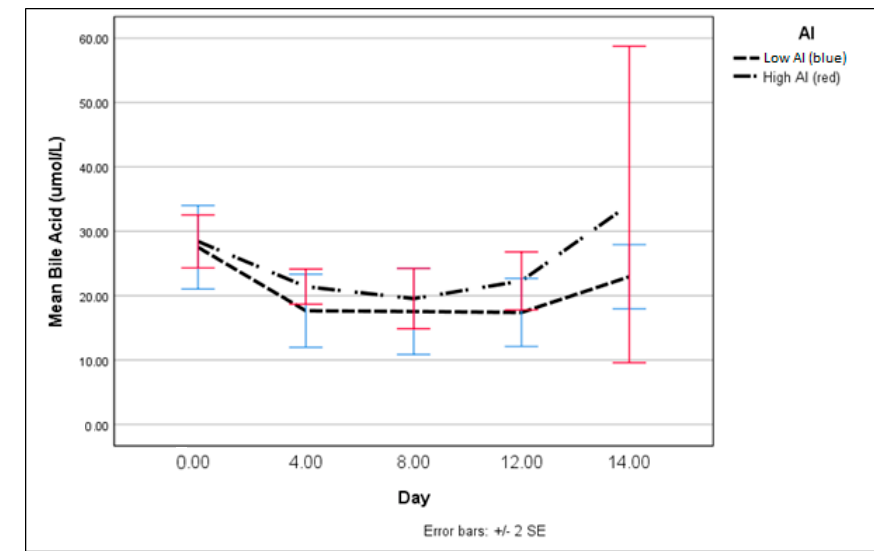
Figure 5. Mean density of microvilli: Canalicular and space of Disse.